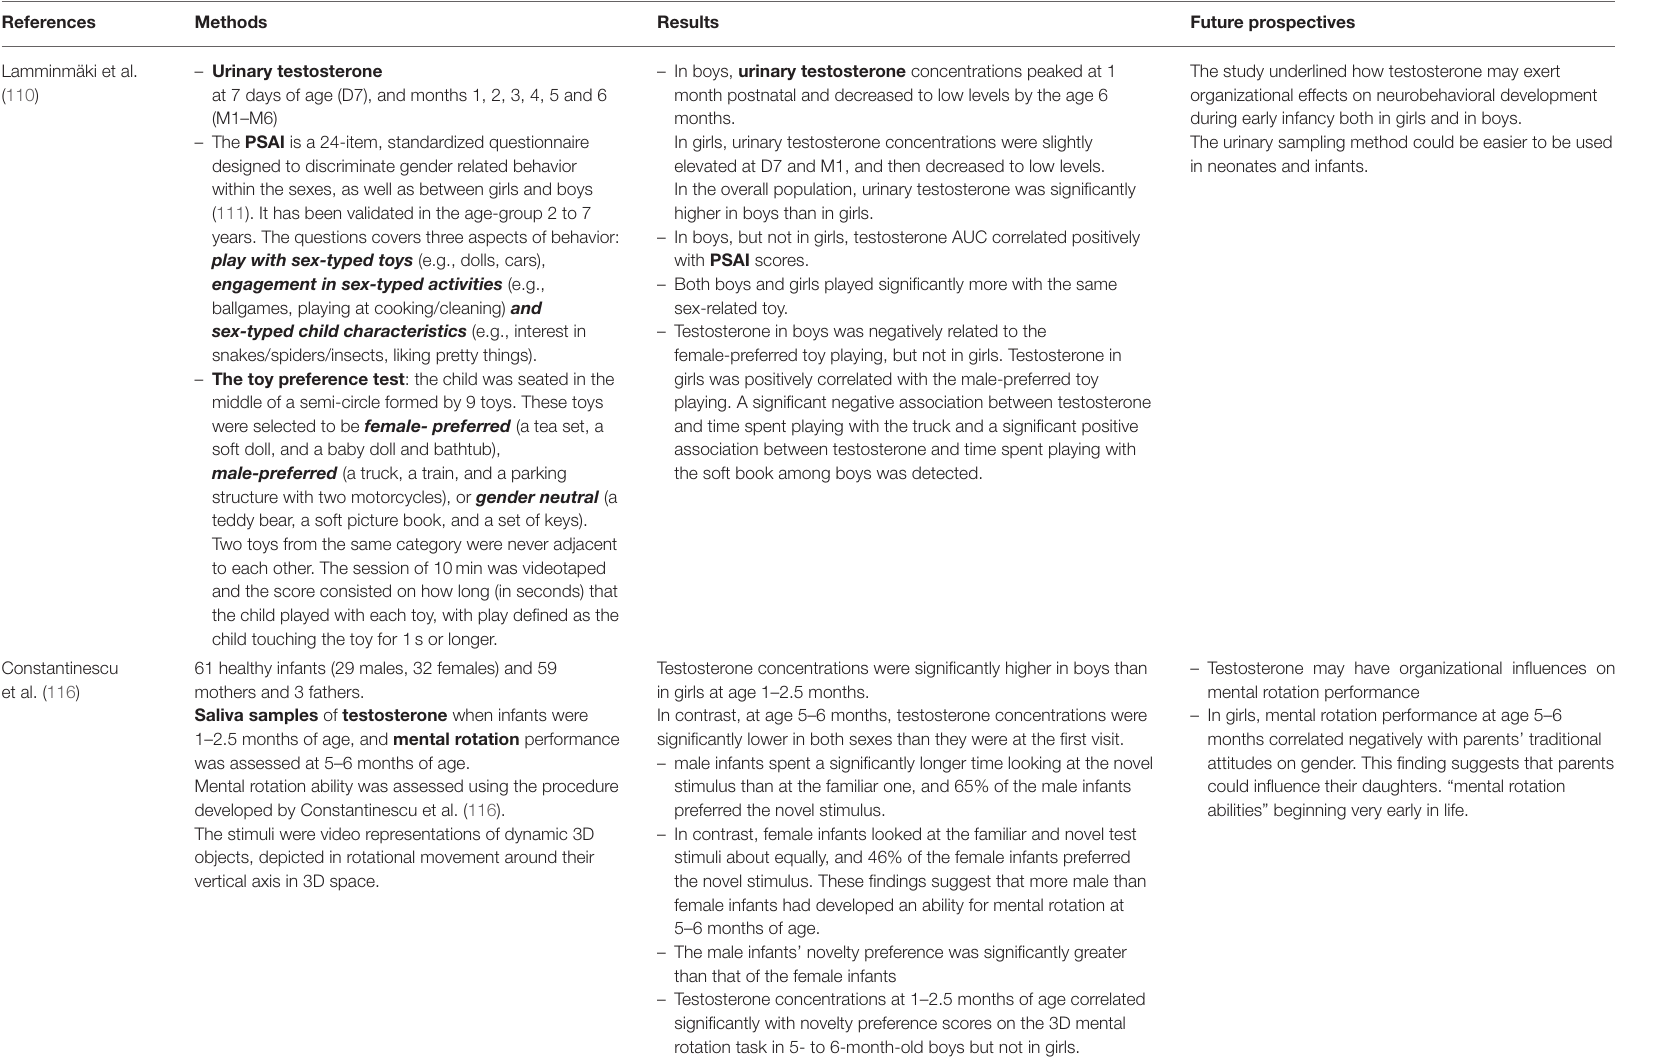
TABLE 2 | Main studies on minipuberty and